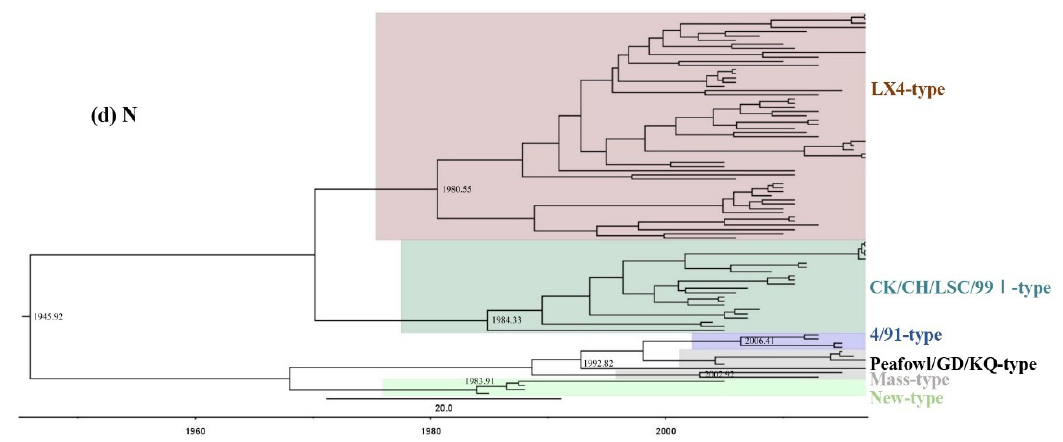
Figure 5. Time-resolved phylogenetic tree of the ( a ) S1, ( b ) E, ( c ) M, and ( d ) N genes of IBV using the Bayesian MCMC method (see Materials and Methods for further details). The MCC tree was constructed with 10% burn-in by Tree Annotator version 1.8.2 implemented in the BEAST software package. A change in branch color indicates a time change during the genotype’s evolutionary history. Numbers beside the branches are branching time. The scale bar represents the unit of time (year).